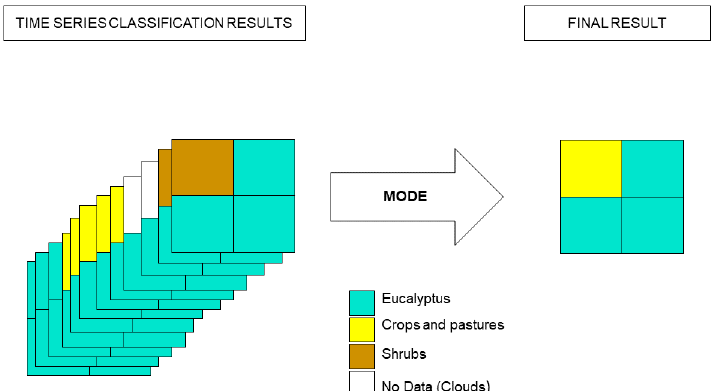
Figure 7. Diagram of the Plurality voting aggregation method used to aggregate the classifica- tion results of the different individual classifications throughout a time series to obtain one final classification. Method developed by Lewi´nski et al. [22] (2017).